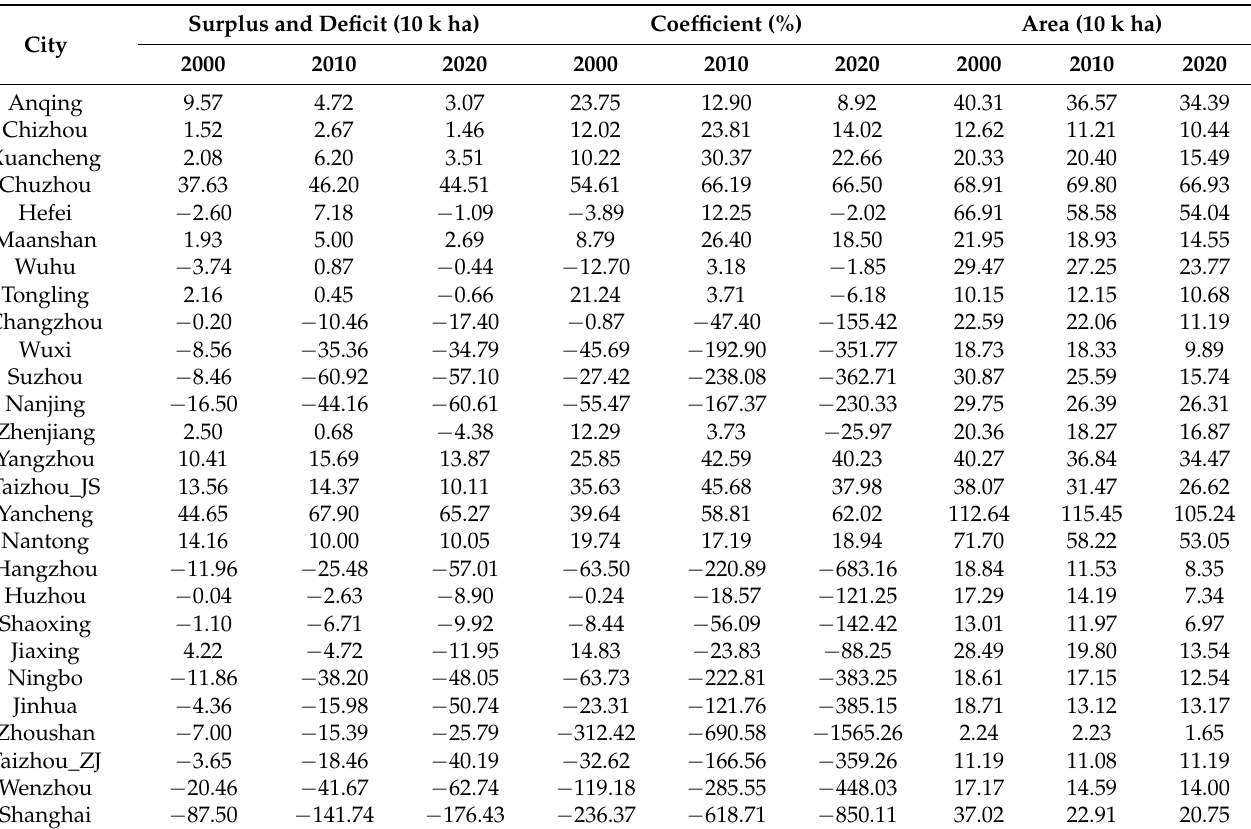
Table 3. Farmland surplus and deficit at city